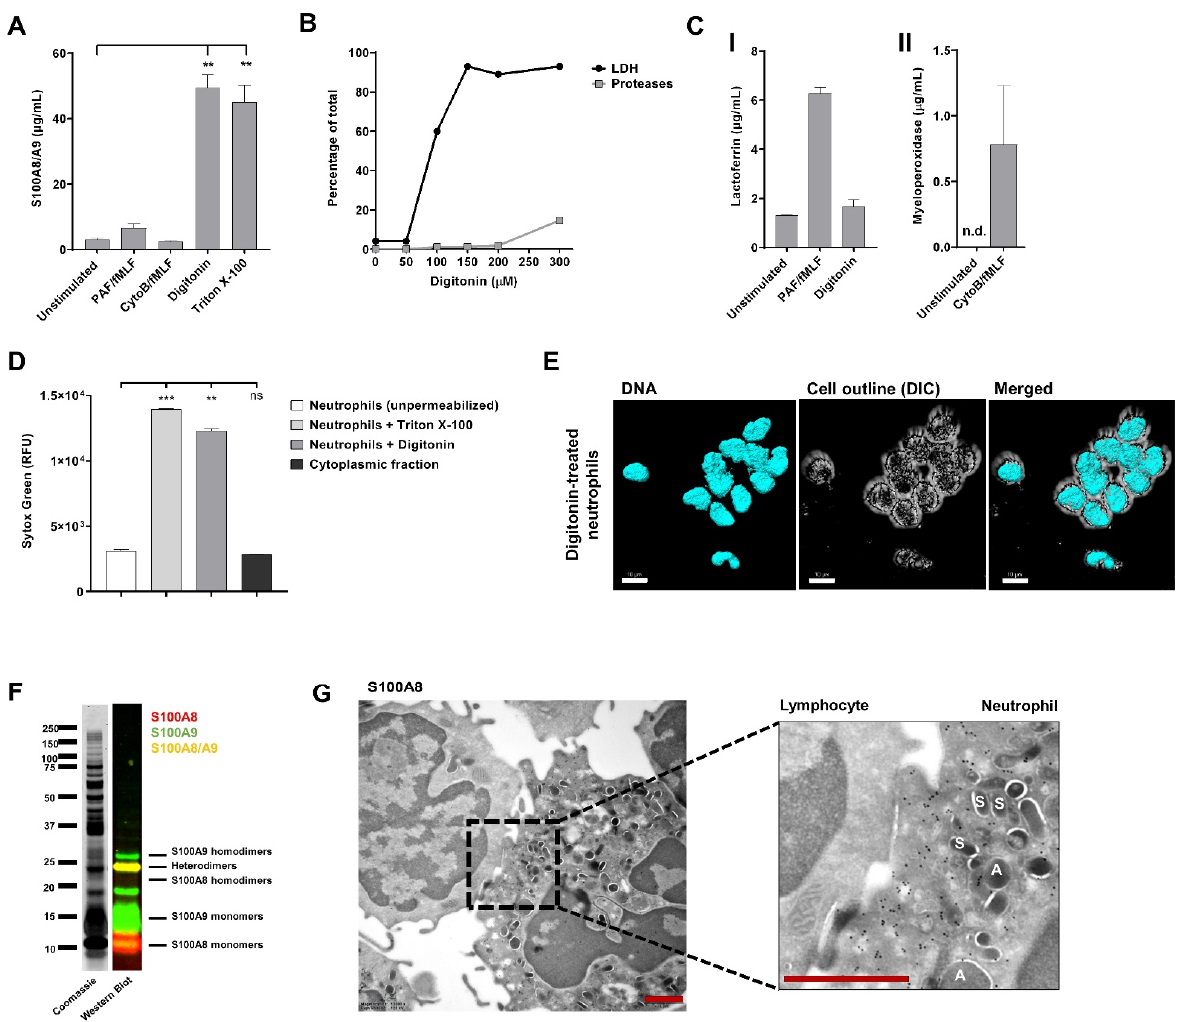
Figure 1. S100A8/A9 is not released during exocytosis. ( A ) Neutrophils (5 × 10 5 ) from healthy controls were left unstimulated or incubated with PAF (1 µ M, 5 min) or cytochalasin B (5 µ g/mL, 5 min) and subsequently stimulated with fMLF (1 µ M) for 10 min at 37 ◦ C. To obtain the cytoplasmic fraction of neutrophils, digitonin (150 µ M, 15 min) was used to permeabilize the plasma membrane of neutrophils. As a positive control, neutrophils were permeabilized with Triton X-100 (1%, 10 min). S100A8/A9 concentration was determined by ELISA (n = 4–6, mean + SEM). ( B ) Experiment to determine the optimal concentration of digitonin to isolate the cytoplasmic fraction. Lactate dehydrogenase (LDH) levels and protease levels were measured and are presented as percentage of their total content (n = 1). ( C ) Panel I: Lactoferrin concentration in supernatant of unstimulated, PAF/fMLF-stimulated neutrophils, or the cytoplasmic fraction of neutrophils was determined by ELISA (n = 2, mean + SEM). Panel II: Myeloperoxidase concentration in supernatant of unstimulated or CytoB/fMLF-stimulated neutrophils was determined by ELISA (n = 2, mean + SEM). ( D ) Presence of DNA was measured with Sytox Green Nucleic Acid Stain (n = 3, mean + SEM). ( E ) Representative image of digitonin-treated neutrophils. DNA was visualized with Hoechst (blue, 405). Images were acquired using a Leica SP8 confocal microscope, magnification 630x, scale bar = 10 µ m. ( F ) Coomassie Brilliant Blue staining and Western Blot for S100A8 (red) and S100A9 (green) of the cytoplasmic fraction of neutrophils. ( G ) Representative immuno-electron microscopy image of a neutrophil (right) and lymphocyte (left) stained for anti-S100A8 (black dots). Scale bar = 1 µ m. “A” indicates azurophilic granules and “S” indicates specific granules. S100A8 is not present in neutrophil granules. Statistics were performed by mixed effects’ model ( A ) or one-way ANOVA ( D) with Dunnett post hoc test; ** p < 0.01, *** p < 0.001, ns = not significant; n.d. = not